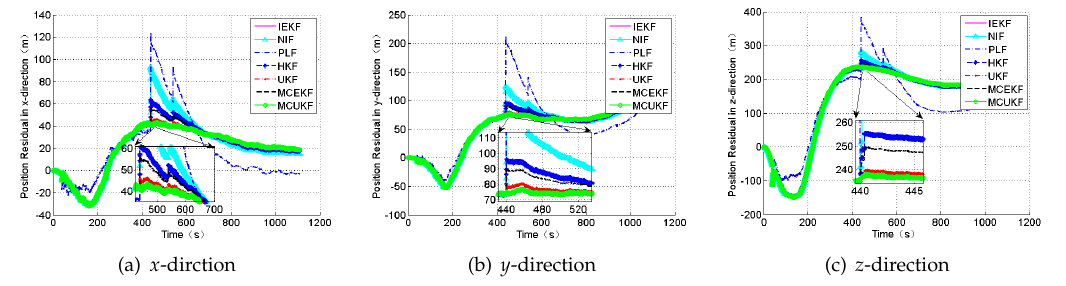
Figure 10. The position residual under the condition of the large outliers.